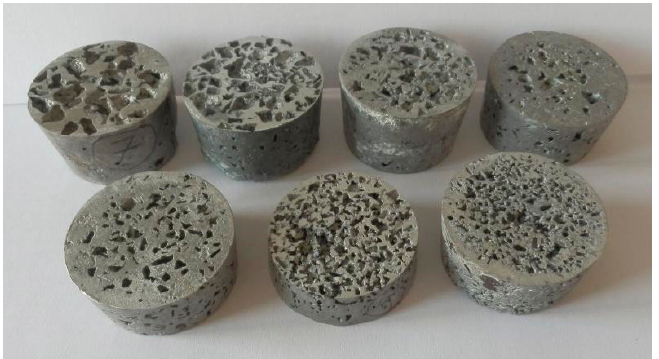
Figure 6. View of manufactured samples of aluminium porous material, AlSi12 alloy, in the shape of a truncated cone (the samples are not sorted by number). Table 4. Basic dimensions and density of produced samples from aluminum porous material.